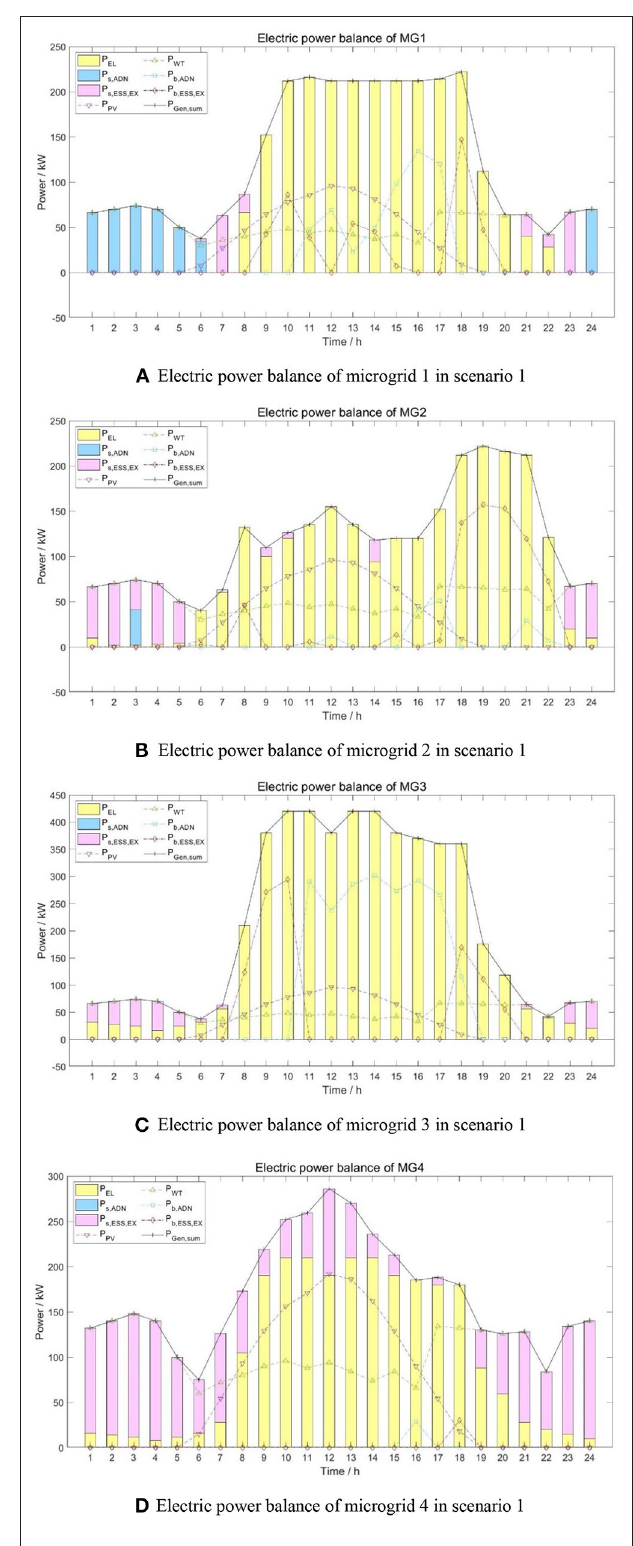
FIGURE 3 | Electric power balance of microgrids in scenario 1. (A) Electric power balance of microgrid 1 in scenario 1. (B) Electric power balance of microgrid 2 in scenario 1. (C) Electric power balance of microgrid 3 in scenario 1. (D) Electric power balance of microgrid 4 in scenario